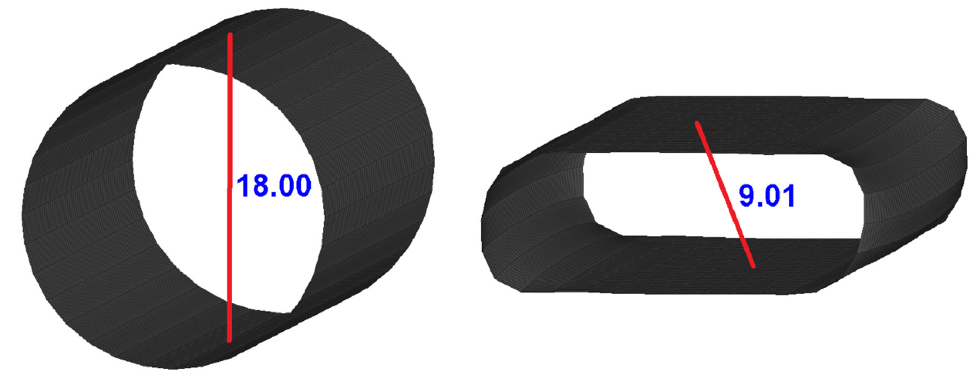
Figure 17. An exemplary pair of nodes on the cell case used for the radial geometric criterion.